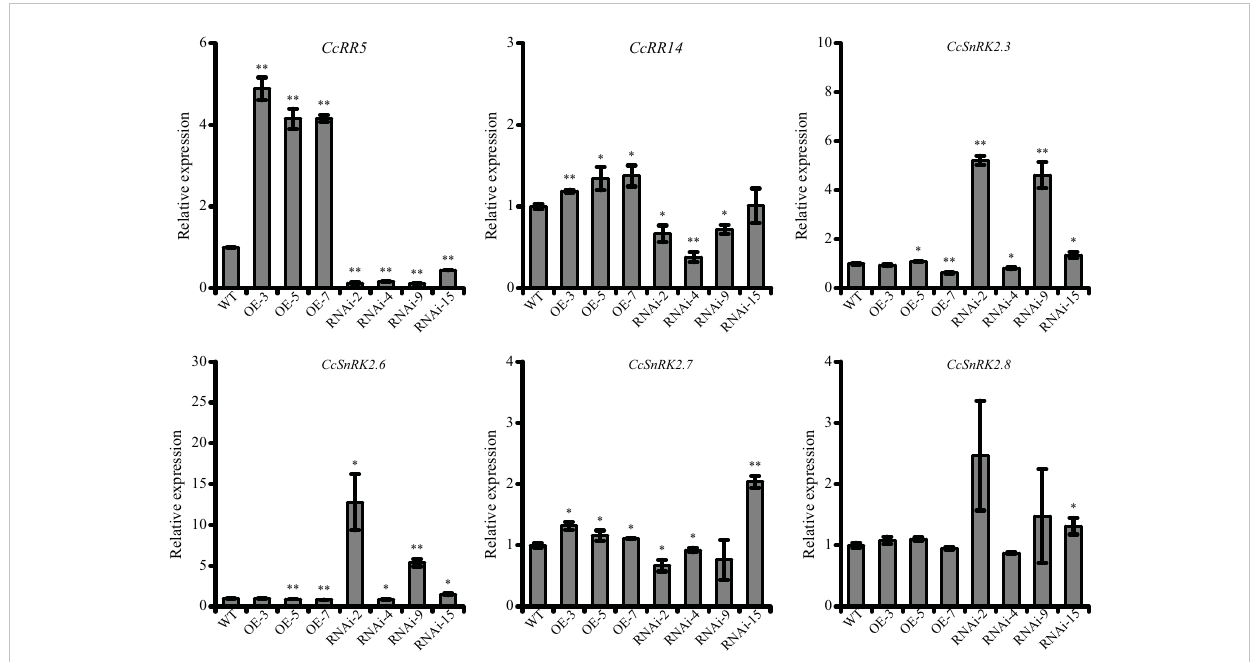
FIGURE 6 The expression level of CcRR5 , CcRR14 , and CcSnRK2s in transgenic plants. WT, wild type; OE, CcRR5 overexpression plants; RNAi, CcRR5 silence plants. Each error bar indicated the mean ± SD ( n = 3). The asterisk indicated that the expression of CcRRs or CcSnRK2s in overexpression and silence plant was signi fi cantly different with that in the WT plants, * p < 0.05; ** p < 0.01.